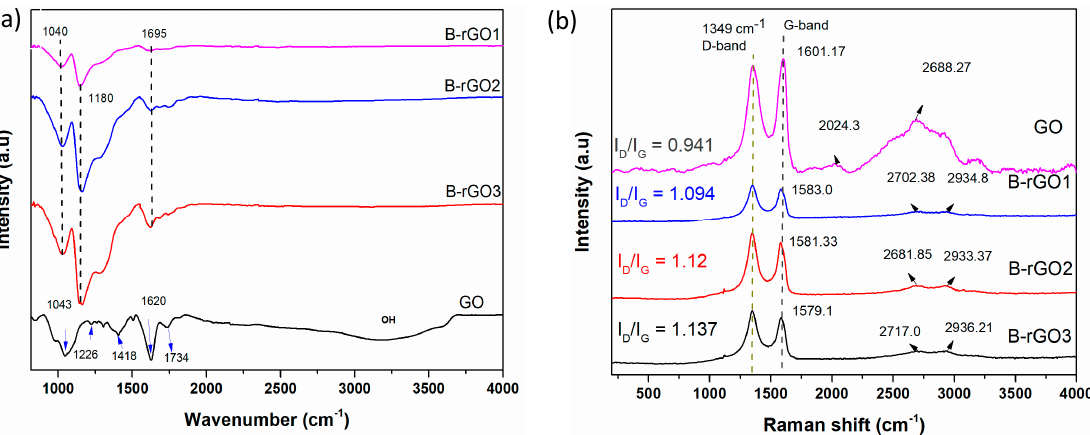
Figure 2. ( a ) FTIR and ( b ) Raman spectra of B-rGO1, B-rGO2, B-rGO3, and GO.